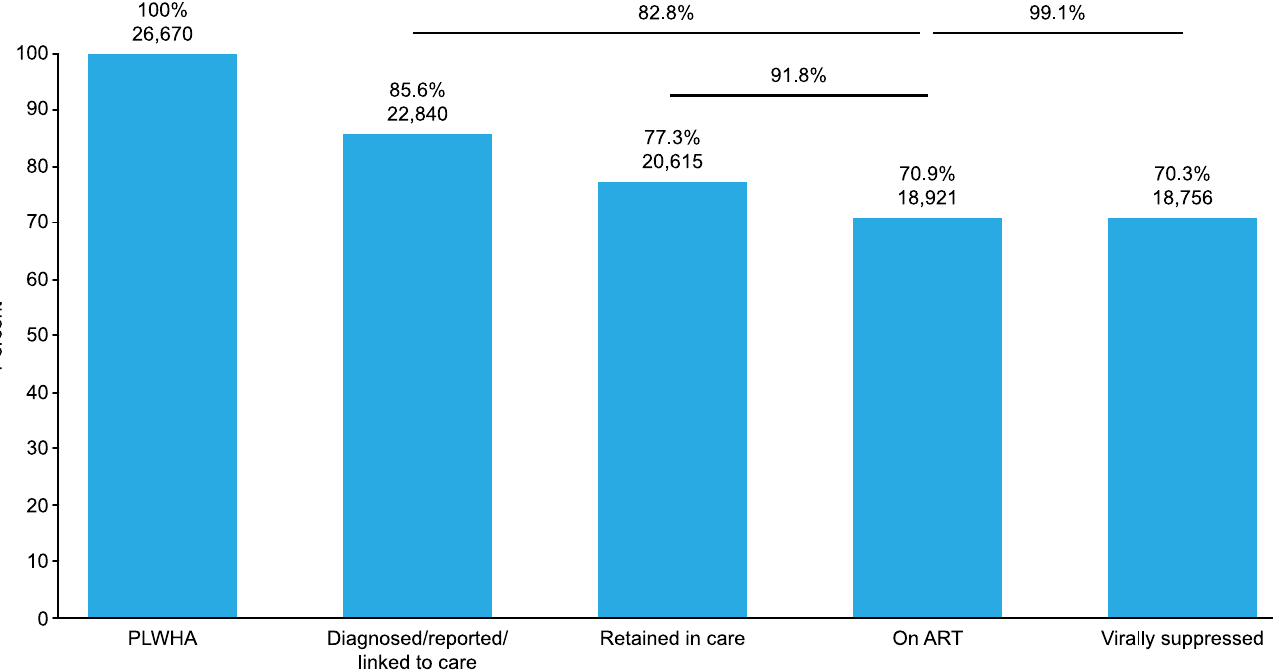
PLOS ONE | https://doi.org/10.1371/journal.pone.0174360 March 20,